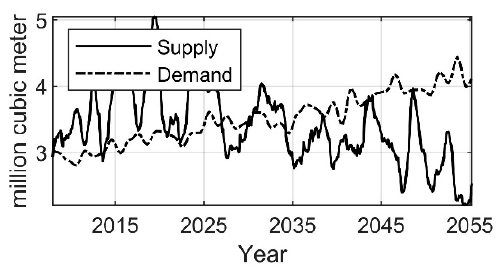
Figure 5. 12-month average of projected water supply and water demand under hot-dry scenario.